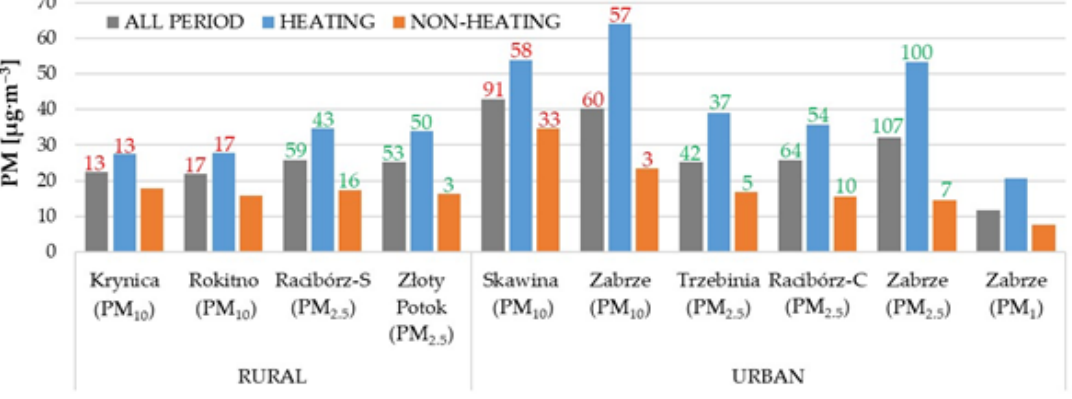
Figure 3. Average concentrations of PM from considered rural and urban background stations. The numbers above each bar symbolize the number of exceedances of the limit value for the average daily PM 10 concentration [20] (red) and the recommended value for the average daily PM 2.5 concentration [52] (green). Designations: ALL—all periods; H—heating season; NH—non-heating season.